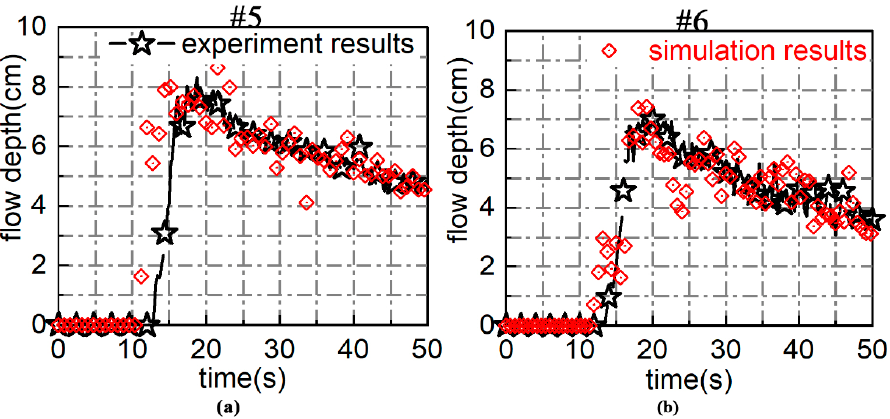
Figure 7. Comparison between experiment result and simulation result. (a) water depth at #5 probe